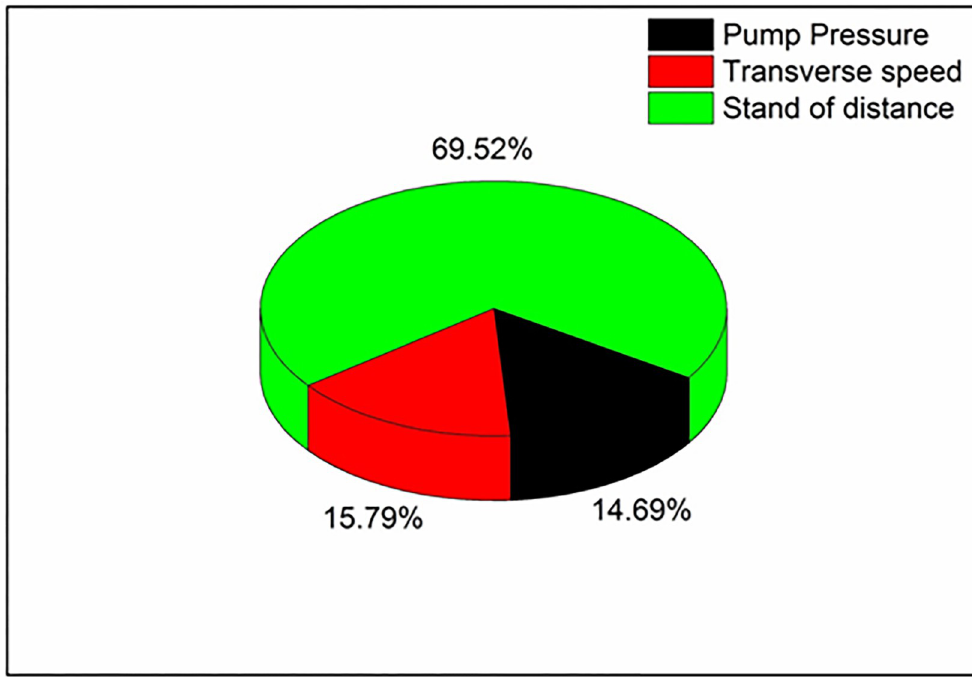
Fig 10. Contribution of machining parameters in 0.2 wt. % filler loaded